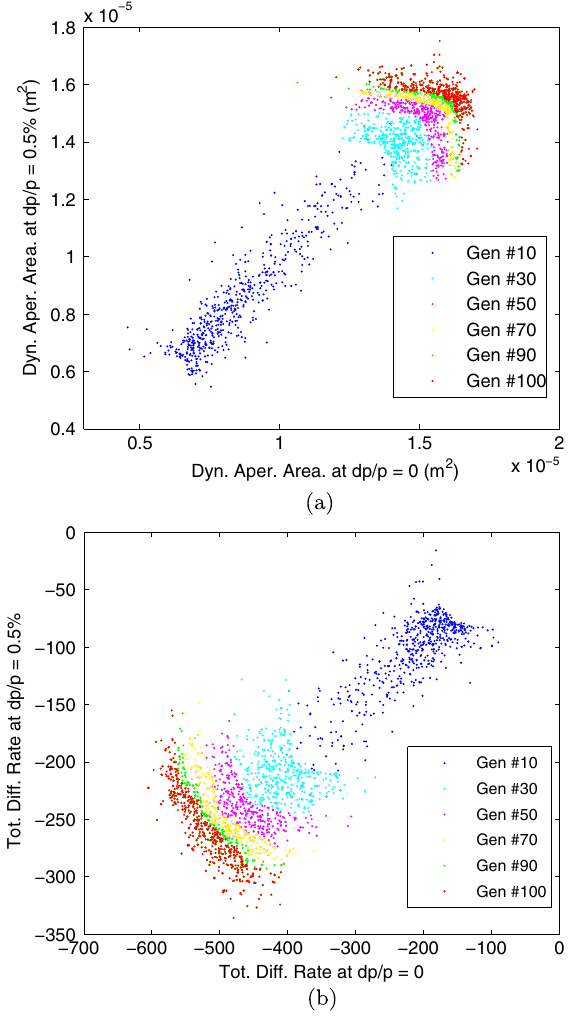
FIG. 6. Lattice solutions at different generations in objective space: (a) optimization using dynamic aperture area as objective; (b) optimization using total diffusion rate as